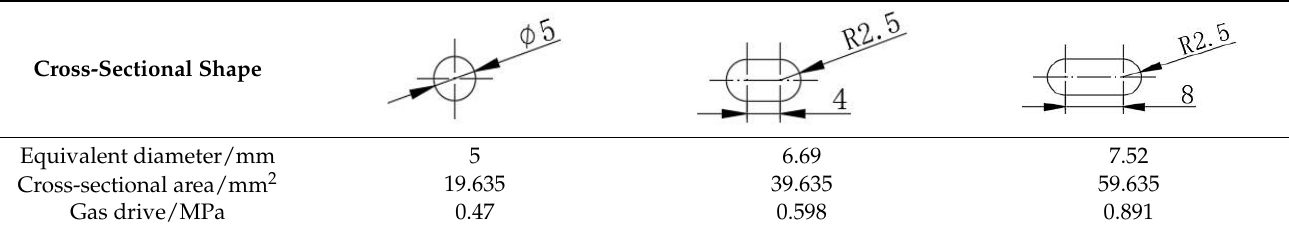
Figure 10. Influence of two sections of the inlet pipe on the gs driving force. ( a ) Inlet pipe circular section. ( b ) Inlet pipe oval section. Table 1. Variation of gas driving force with intake tube cross section.